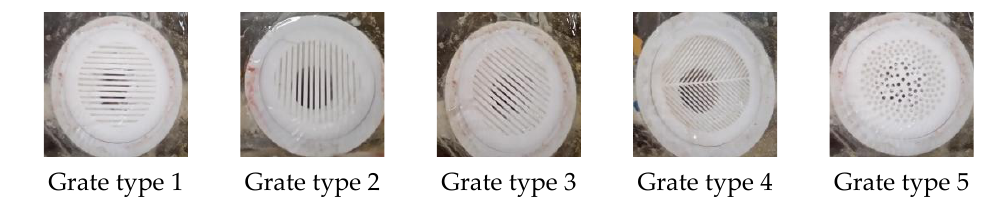
Figure 6. Grate shapes used in the study.